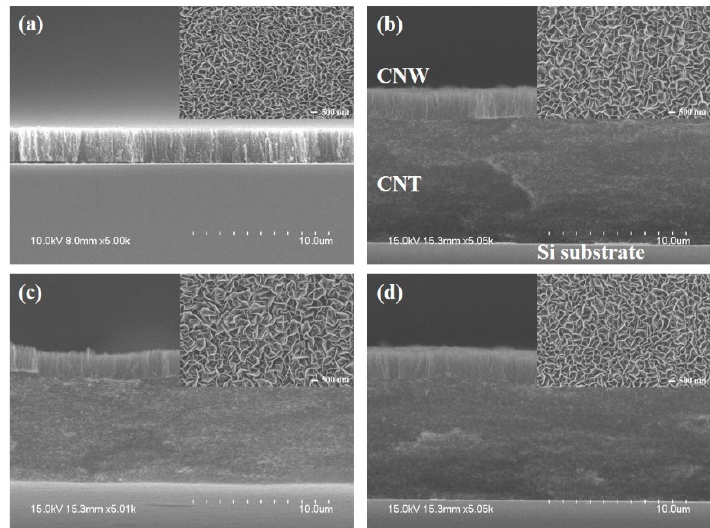
Figure 2. The image of surface (inset) and cross section FE-SEM: ( a ) pristine MWCNT ( b ) CNT (30 µL)/CNW; ( c ) MWCNT (50 µL)/CNW; ( d ) MWCNT (70 µL)/CNW.